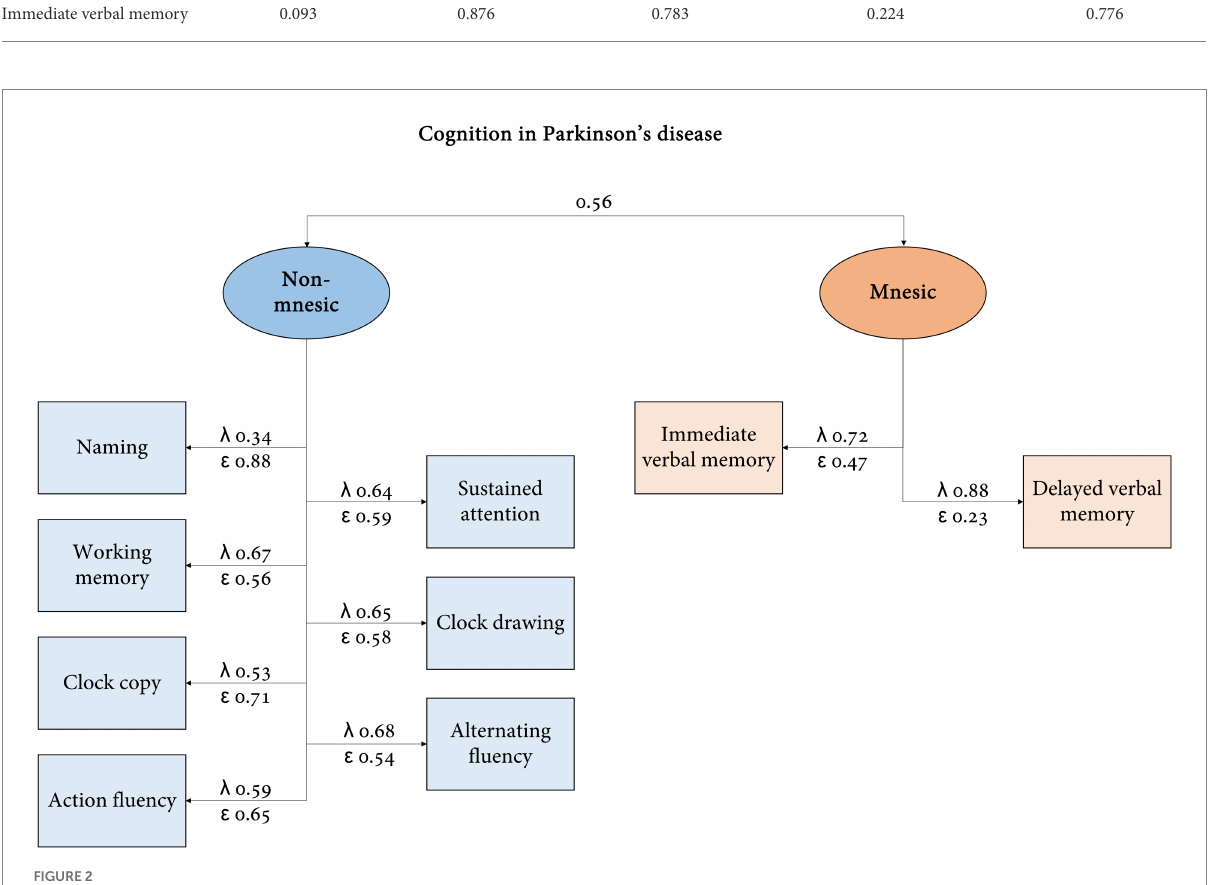
FIGURE 2 Structural model for cognition in PD by domains and